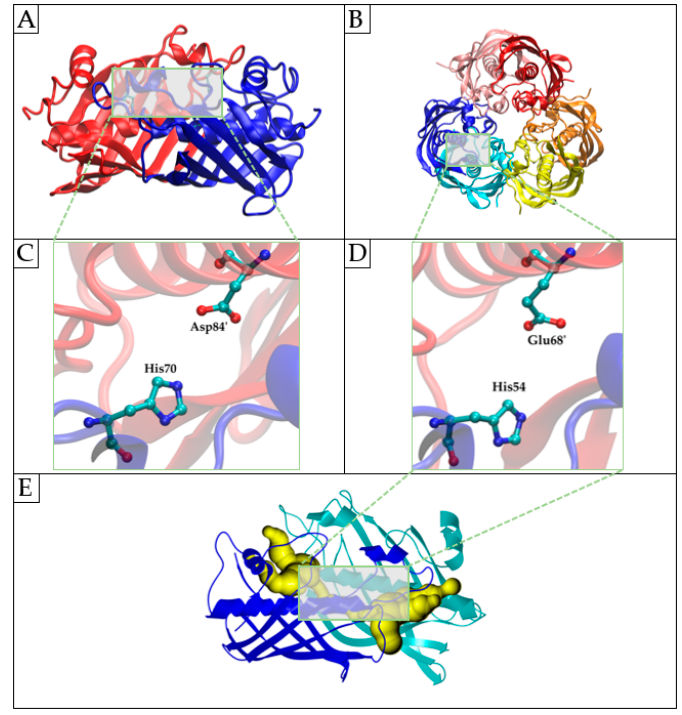
Figure 20. ( A ) Ec FabA apo-dimer (PDB ID 1MKB) structure. One FabA monomer is coloured in blue, the other in red. ( B ) Ec FabZ trimer of dimers (PDB ID 6N3P) structure. In each dimer, FabZ